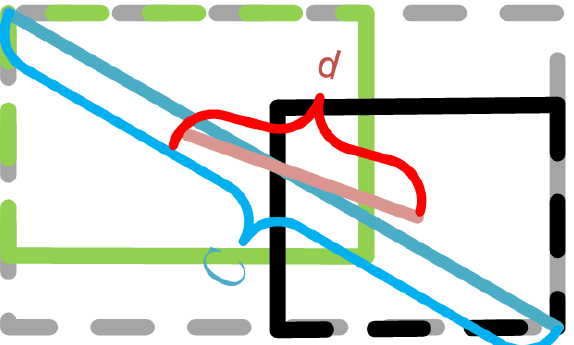
Figure 5. DIoU loss for bounding box regression, where the normalized distance between central points can be directly minimized. c is the diagonal length of the smallest enclosing box covering two boxes, and d = ρ ( b , b gt ) is the distance of central points of two